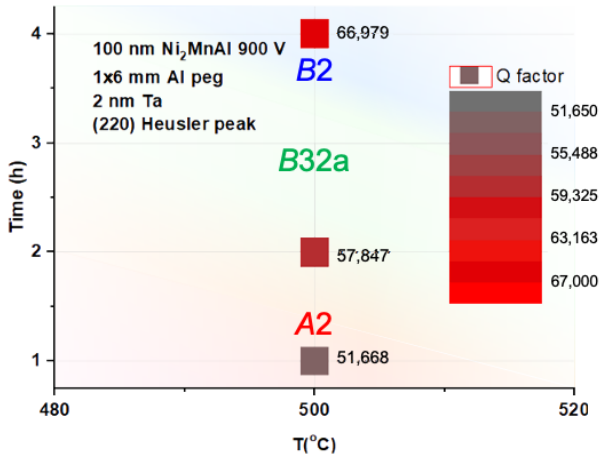
Figure 5. Crystallisation of the ordered Ni 2 MnAl thin films doped with a 6 mm Al peg indicated by Q factors.